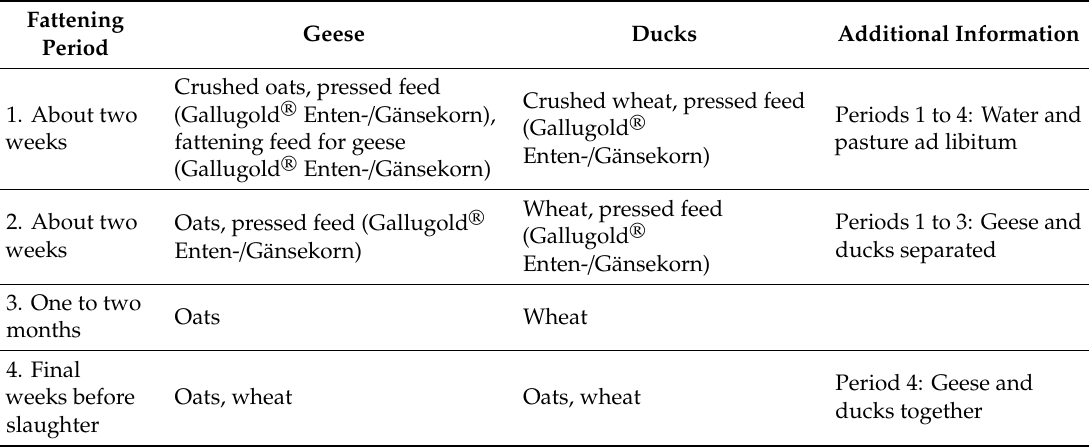
Table 1. Feeding schedule: overview of the di ff erent phases of the rearing feeding of the two